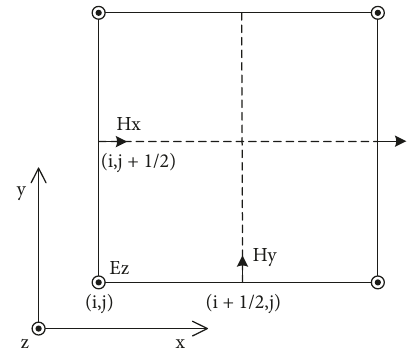
Figure1:Schematicdiagramofpositionoftheelectricandmagnetic field vector of the Yee TM